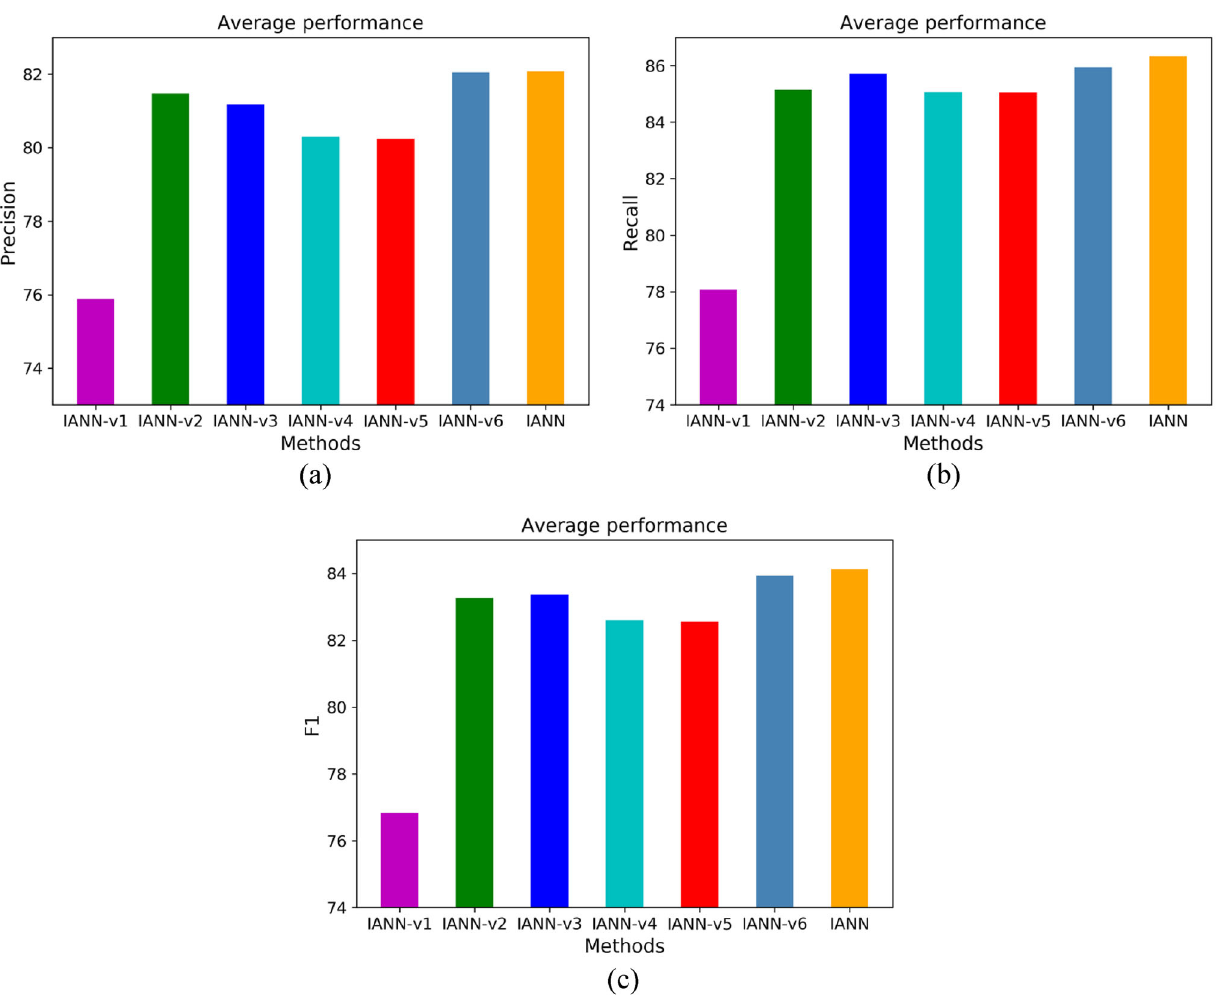
Fig. 7 The average performance of variants of IANN on all datasets. a Shows the average precision, b shows the average recall, c shows the average F1